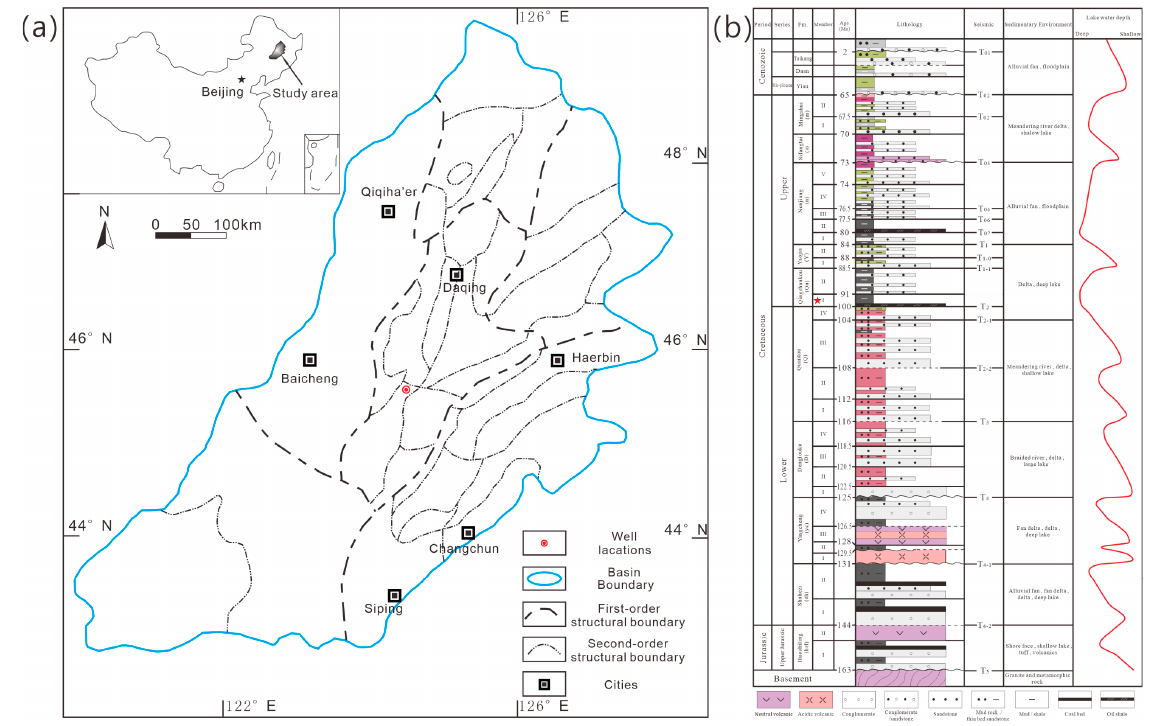
Figure 1. ( a ) Sampling position (well X1) and the Songliao Basin. ( b ) Lithological sketch in the study area.